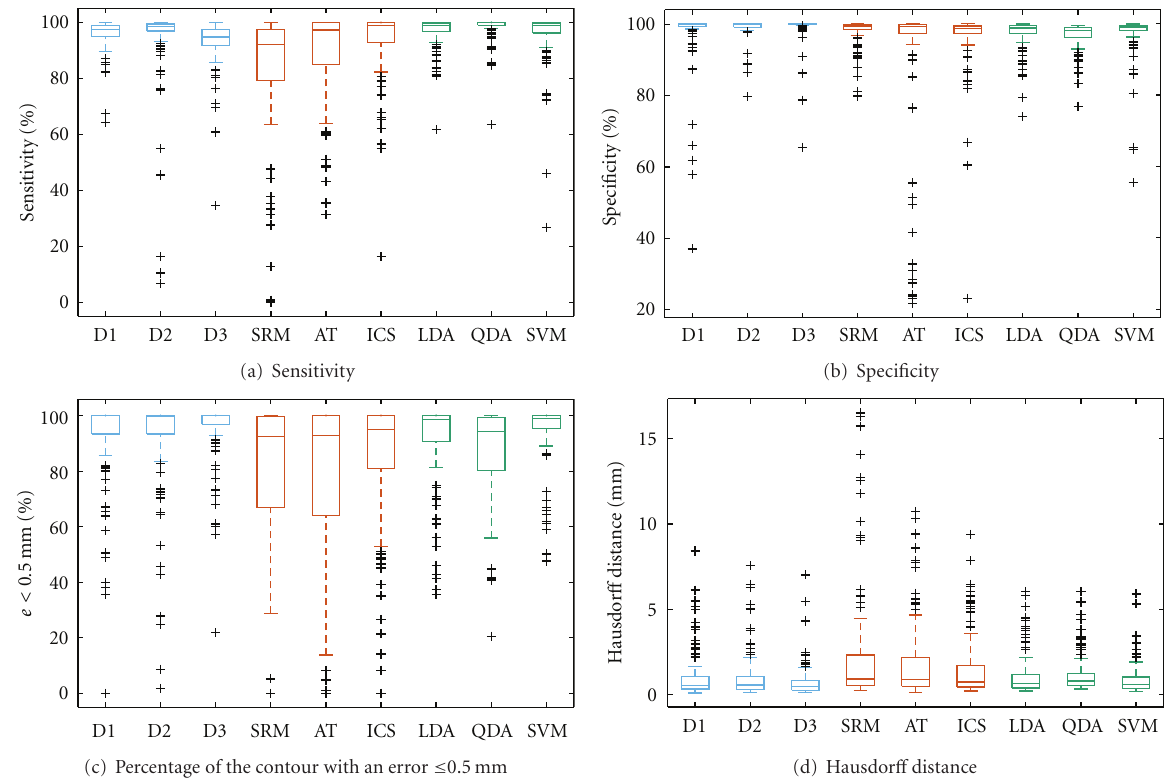
Figure 4: Dispersion of the accuracy of segmentation, quantified by the four distinct border measures, showing the performance of the proposed ICS method against the di ff erent segmentation methods analyzed. D1, D2, and D3 corresponds to the manual segmentations provided by dermatologists. SRM, AT, and ICS are automatic methods. LDA, QDA, and SVM are supervised methods that here include only for reference purposes. The accuracy scores are computed using the mask generated by majority voting of the manual segmentations provided by three dermatologists as ground-truth